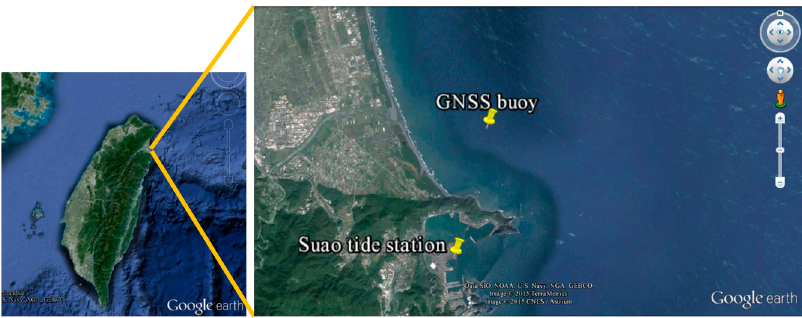
Figure 5. Locations of the GNSS buoy and nearby Suao tide station.